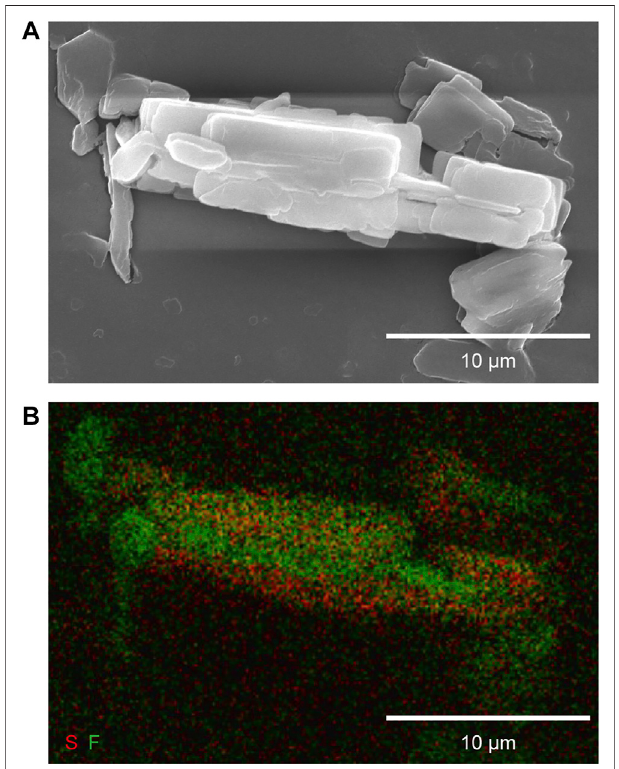
FIGURE 7 | (A) SEM and (B) EDX mapping images of as-synthesized pre-ELM-11@ELM-12 particles.